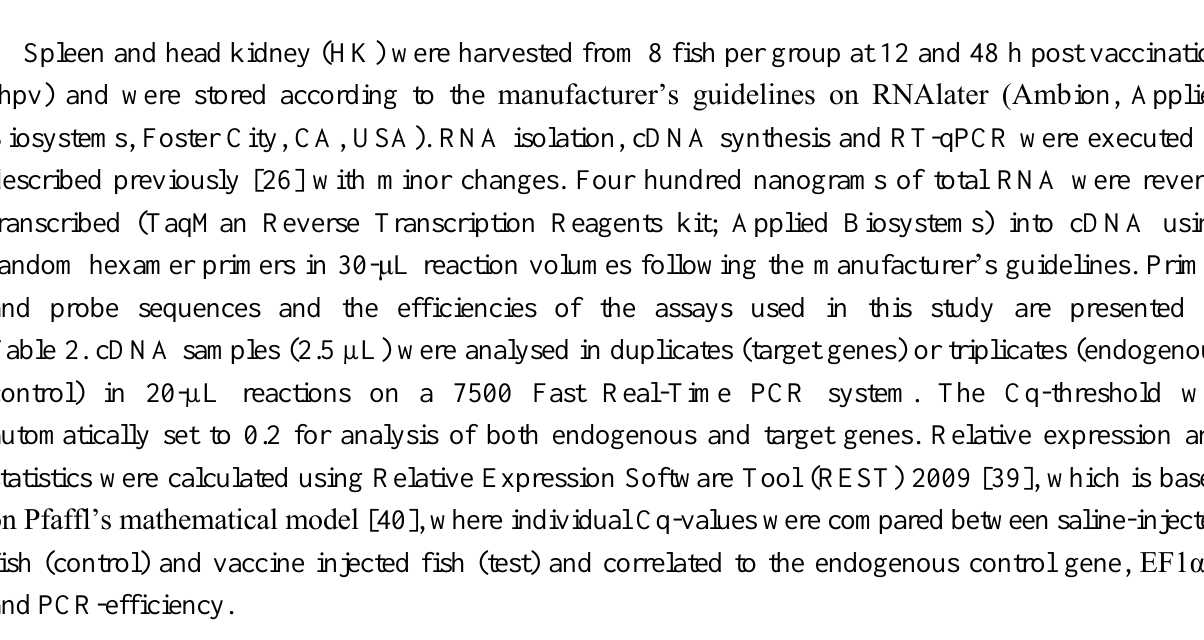
Analysis (# of fish) Total Immune gene nsP1 # of expression fish 12 and 48 hpv